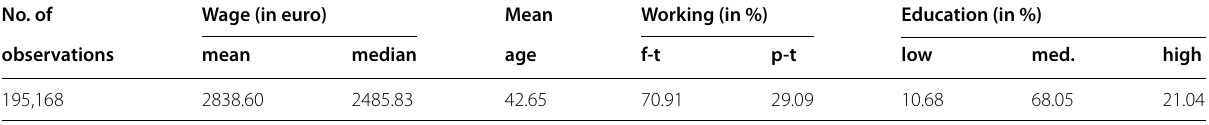
Source: own calculations, SOEP-Core.v37.EU, years 2000–2019 Wage: nominal monthly wage in euro, mean over (median of) all observations of the sample. Age: mean age in years. Working: f-t Education: low no vocational training; medium = Only wages above the marginal earnings threshold are taken into account